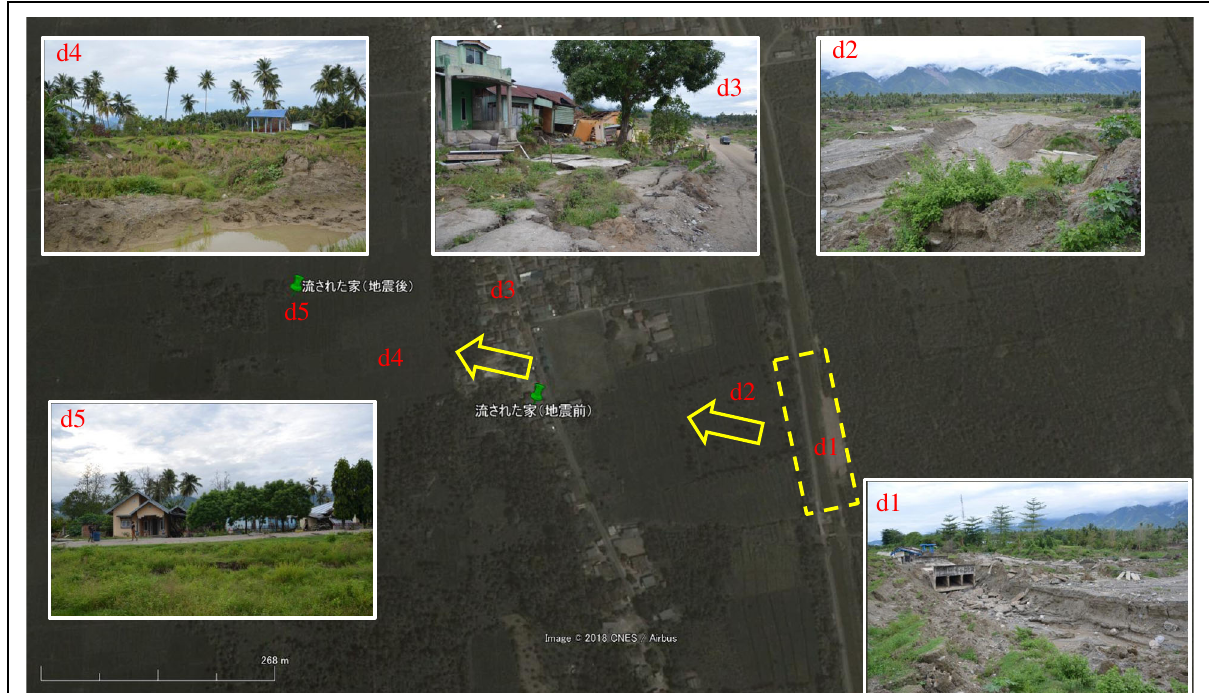
Fig. 12 Satellite photo by Google Earth and some photos of damage in Sibalaya village